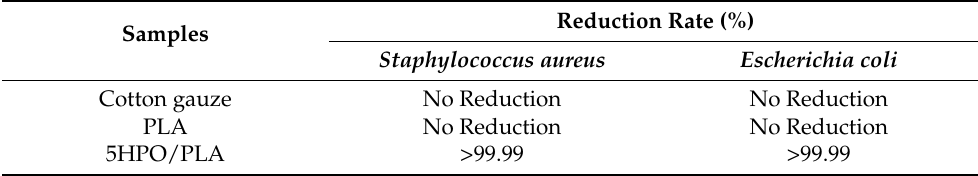
Table 1. Antibacterial activity of the electrospun nonwoven fabrics.